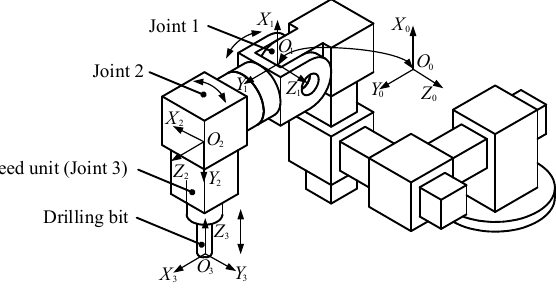
Figure 2. Coordination definition of the end-effector.